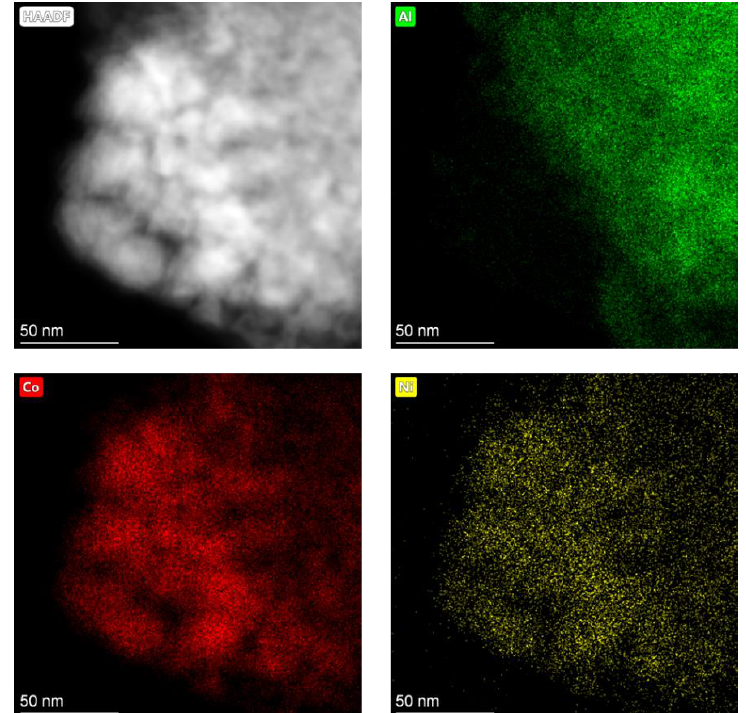
Figure 2. HAADF-STEM image of sample 25%M (10%Ni-90%Co). Elemental mapping legend: (yellow) nickel, (red) cobalt, and (green) aluminum.